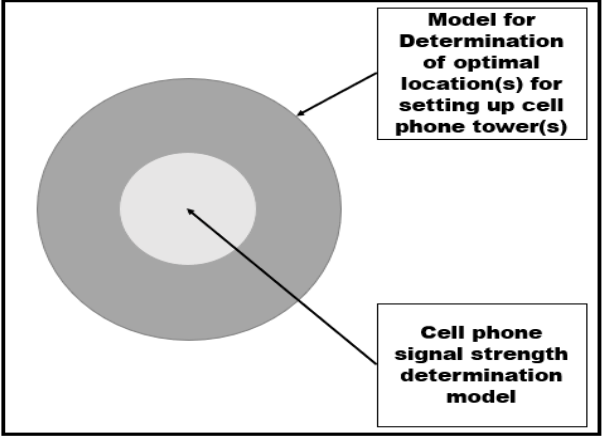
Figure 3. Proposed methodology.